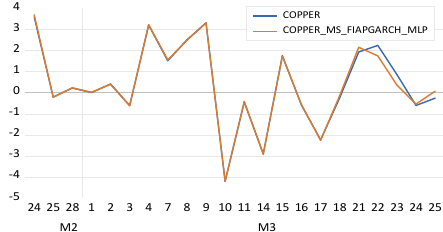
Figure 1. Copper, MS − FIAPGARCH − MLP.